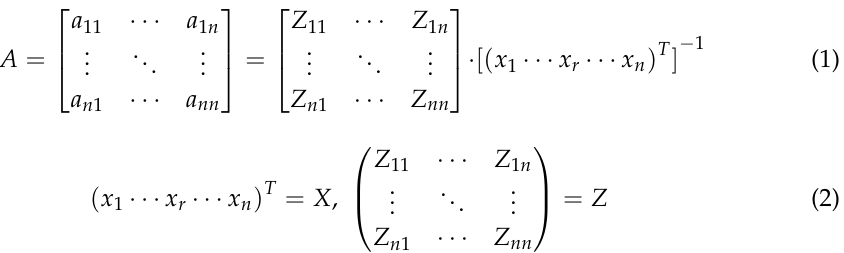
Table 1. Sector Abbreviations.